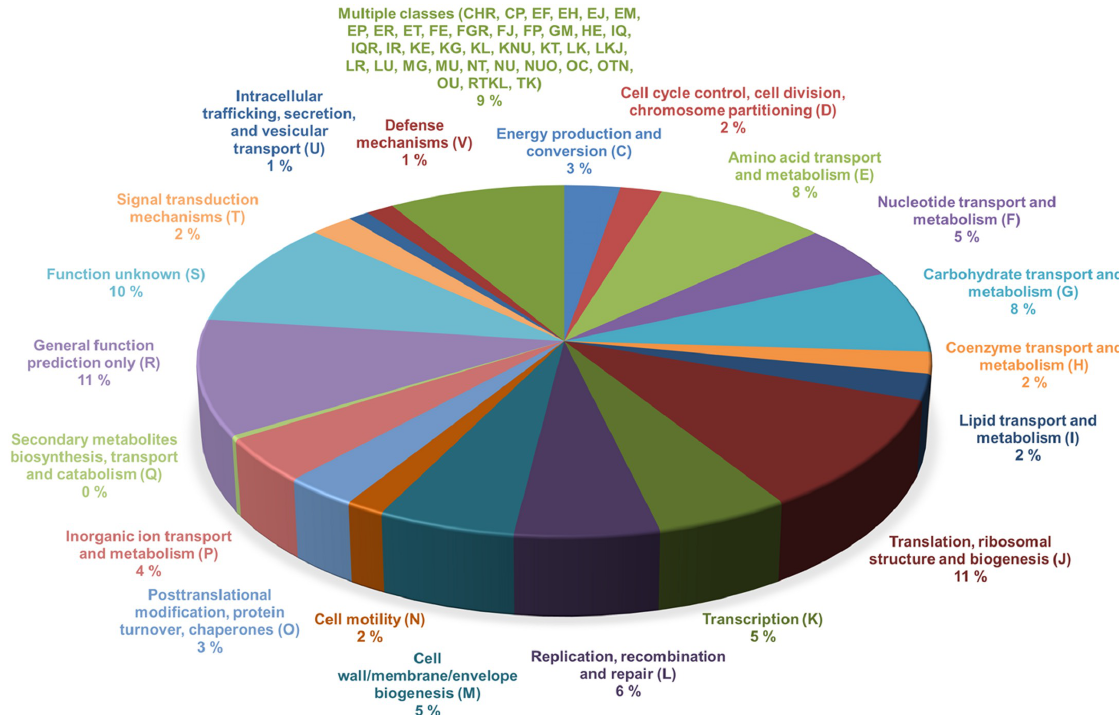
Fig 4. Functional classifications of the L . ruminis core genome. COG (clusters of orthologousgroups) functional classificationswere assignedto the putative proteins of the L . ruminis core genome as describedin Materials and Methods. Various core proteins were categorized accordingto 21 COG functionalassignmentsas a percent of the total number of predicted proteins in the core genepool. Results are shown as a pie chart, with the names and abbreviationsfor the COG categories and the correspondingpercentages (%)